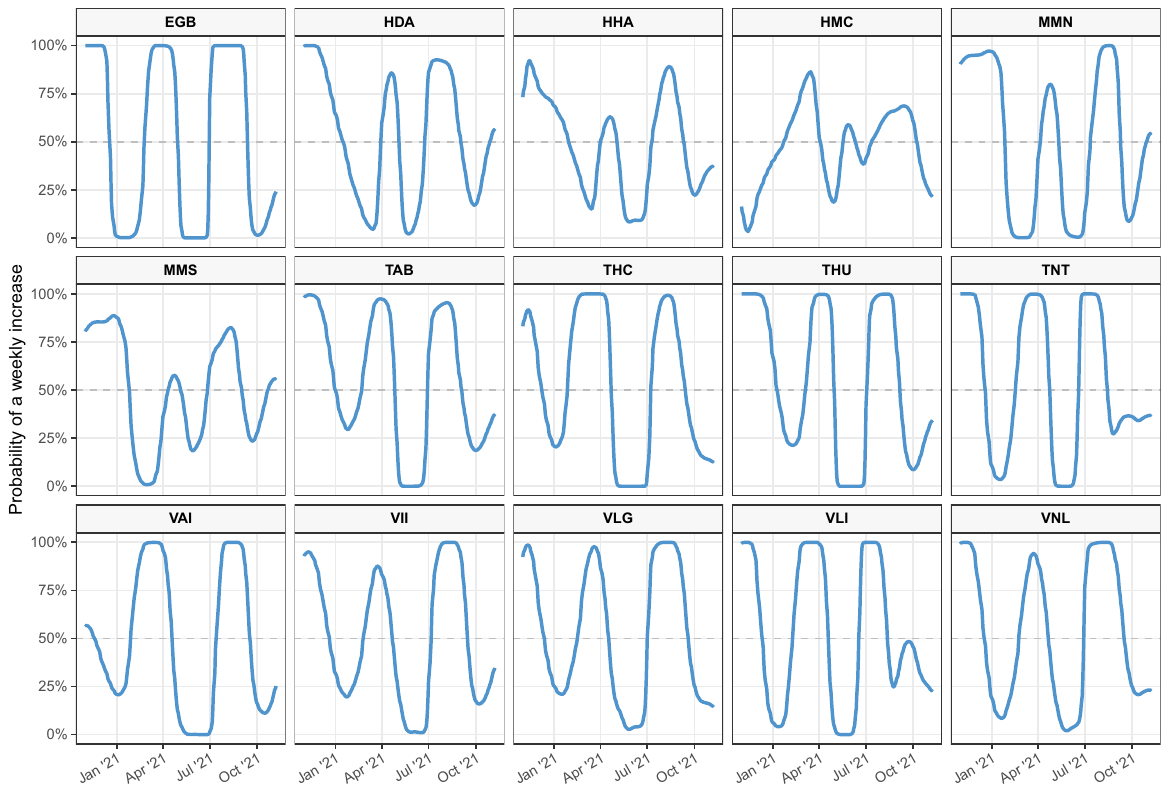
Figure 2. Time series of the probability of weekly increase, that is Proba ( ˆ Y i ( T it ) > ˆ Y i ( T i , t − 7 )) ( D = 7 ) calculated with the comprehensive model (including covariates) for all sampling locations. The horizontal dashed line indicates the 50%